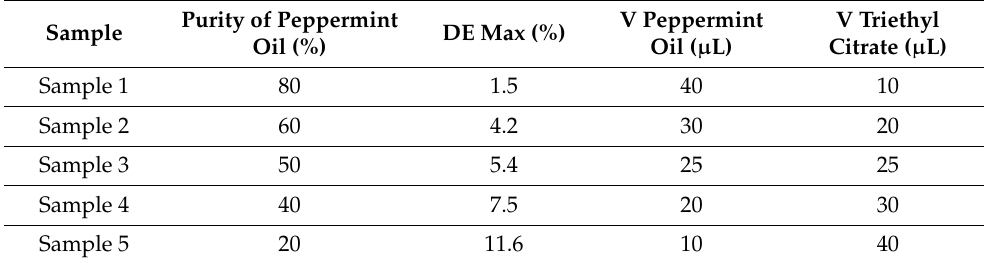
Table 5. Samples of HPDLC/adulterated peppermint oil composite with different purity of the peppermint